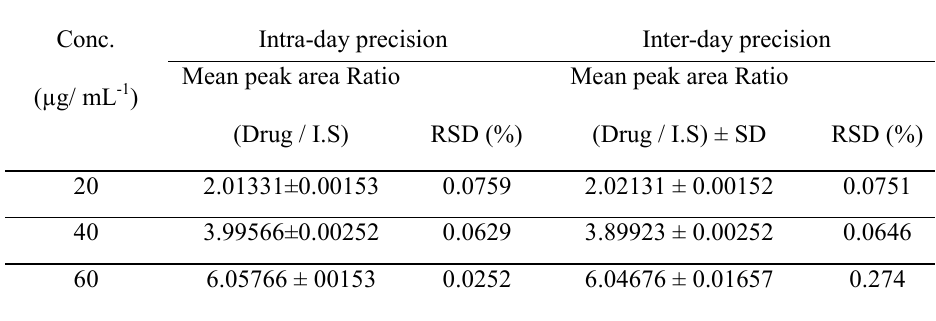
Table 2: Intra-day and inter-day precision for Etoricoxib ( n = 3).